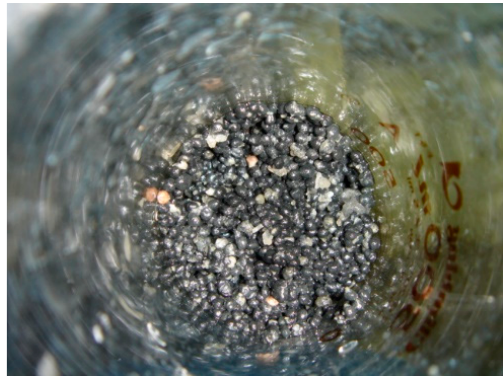
Figure 6. Granular sludge formed in the